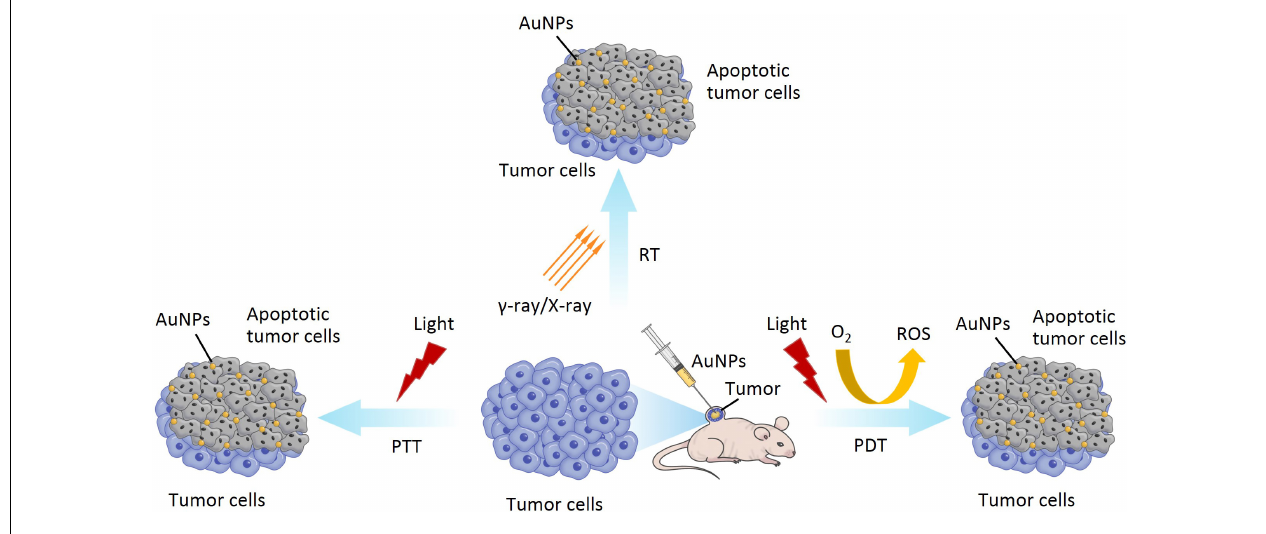
FIGURE 10 | The application of PTT, PDT and RT for AuNPs.